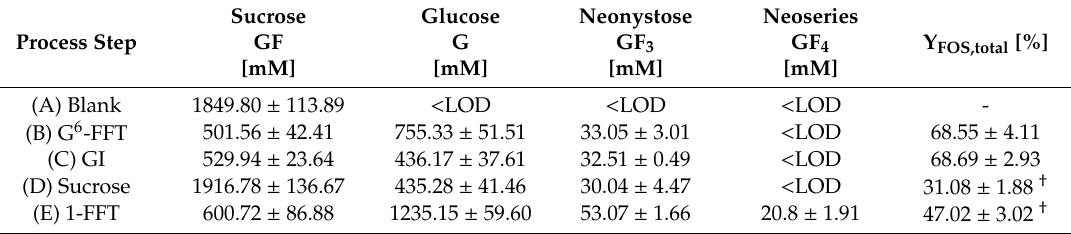
Table 1. Substrate / product concentrations in a two-step neoFOS production process at the 100-mL scale showing each consecutive production step: (A) blank, (B) products of G 6 -FFT catalysis, (C) products of glucose isomerase, (D) concentrations following the addition of crystalline sucrose, and (E) products of 1-FFT